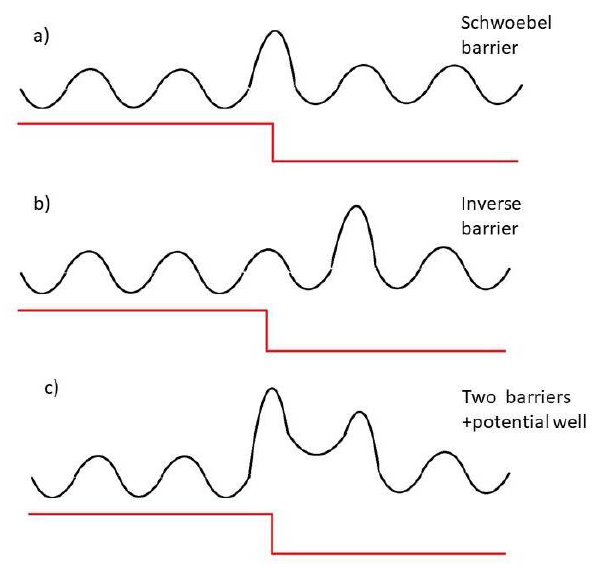
Figure 1. Energy landscape for diffusing particles. ( a ) Direct Ehrlich–Schwoebel (dES) barrier at the top of the step, with jump probability given by P dES . ( b ) Inverse Ehrlich–Schwoebel (iES) barrier below the step with jump probability given by P iES . ( c ) P dES , P iES and the changed depth of the potential well below. The jump rate out of the well is described by parameter p w